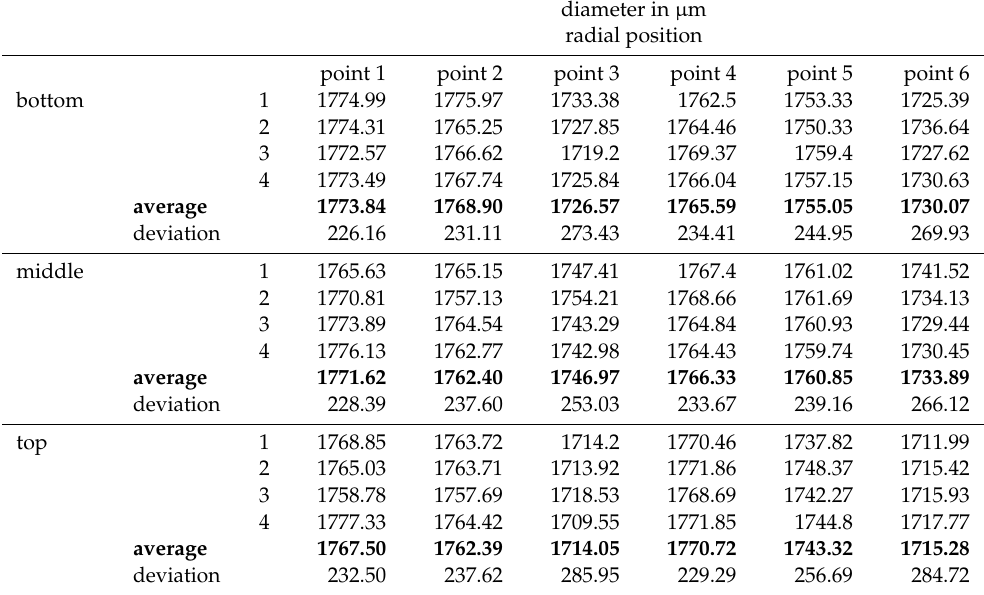
Table 2. Table of measurement results for the diameters of the additive manufactured net structure bars (exemplary from version 1), including average and deviation (target diameter: 2 mm).